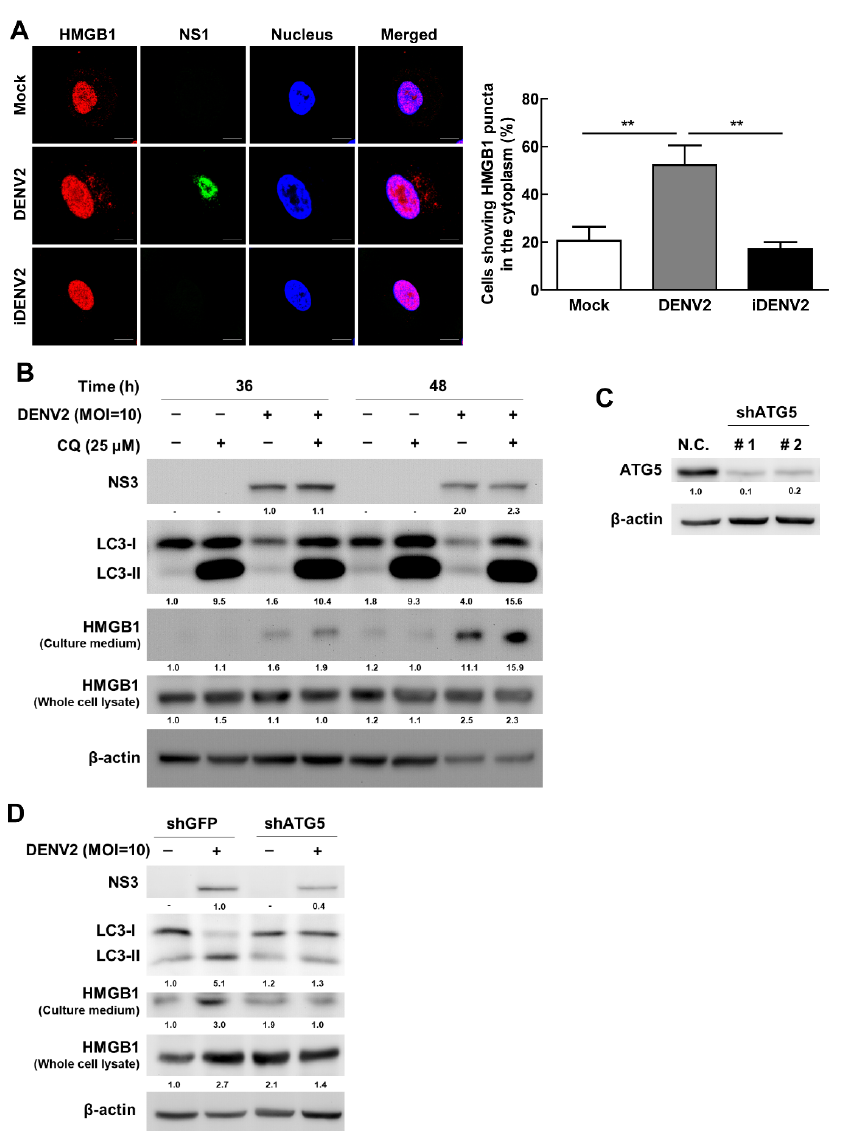
Figure 5. DENV2 triggers HMGB1 exocytosis through unconventional secretory autophagy. ( A ) A549 cells were infected by DENV2 (MOI = 10), or heat-inactivated DENV2 (iDENV2; MOI = 10) for 36 h. The mock treatment was negative control without infection of DENV. Cells were examined for the localization of DENV-NS1 (green) and HMGB1 (red) by confocal microscopy. The quantification was the percentage of cells showing HMBGB1 puncta in the cytoplasm. Scale bar = 10 μm. ** p < 0.01. ( B ) A549 cells were infected with or without DENV2 (MOI = 10) for 12 h and 24 h followed by co-treatment with CQ (25 μM) for another 24 h. The whole-cell lysate and extracellular supernatant were analyzed by immunoblotting for LC3, NS3 and HMGB1 expression using specific antibodies. ( C ) The levels of ATG5 expression in negative control (shGFP) cells or two shATG5 clones were evaluated by immunoblotting. ( D ) The levels of cellular ATG5, LC3, HMGB1, and DENV-NS3 in shGFP or shATG5 cells and released-HMGB1 expression in culture medium with or without DENV2 infection were investigated by immunoblotting.